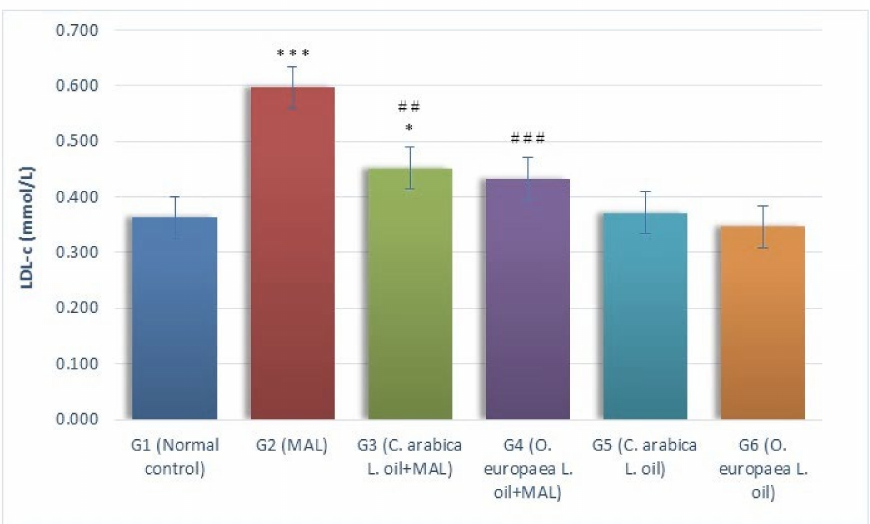
Figure 3. Influence of Coffea arabica L. oil and Olea europaea L. oil on the serum LDL-c levels. When a comparison was made against the normal control group, a significant difference was found in the mean values at p ≤ 0.05 *; p ≤ 0.001 ***. When a comparison was made against the MAL-intoxicated rats, a significant difference was found in the mean values at p ≤ 0.01 ## ; p ≤ 0.001 ### . A substantial ( p ≤ 0.001) increment was reported in serum VLDL-c (mmol/L) levels in G2 animals (MAL-intoxicated), as measured against the G1 group (i.e., the normal